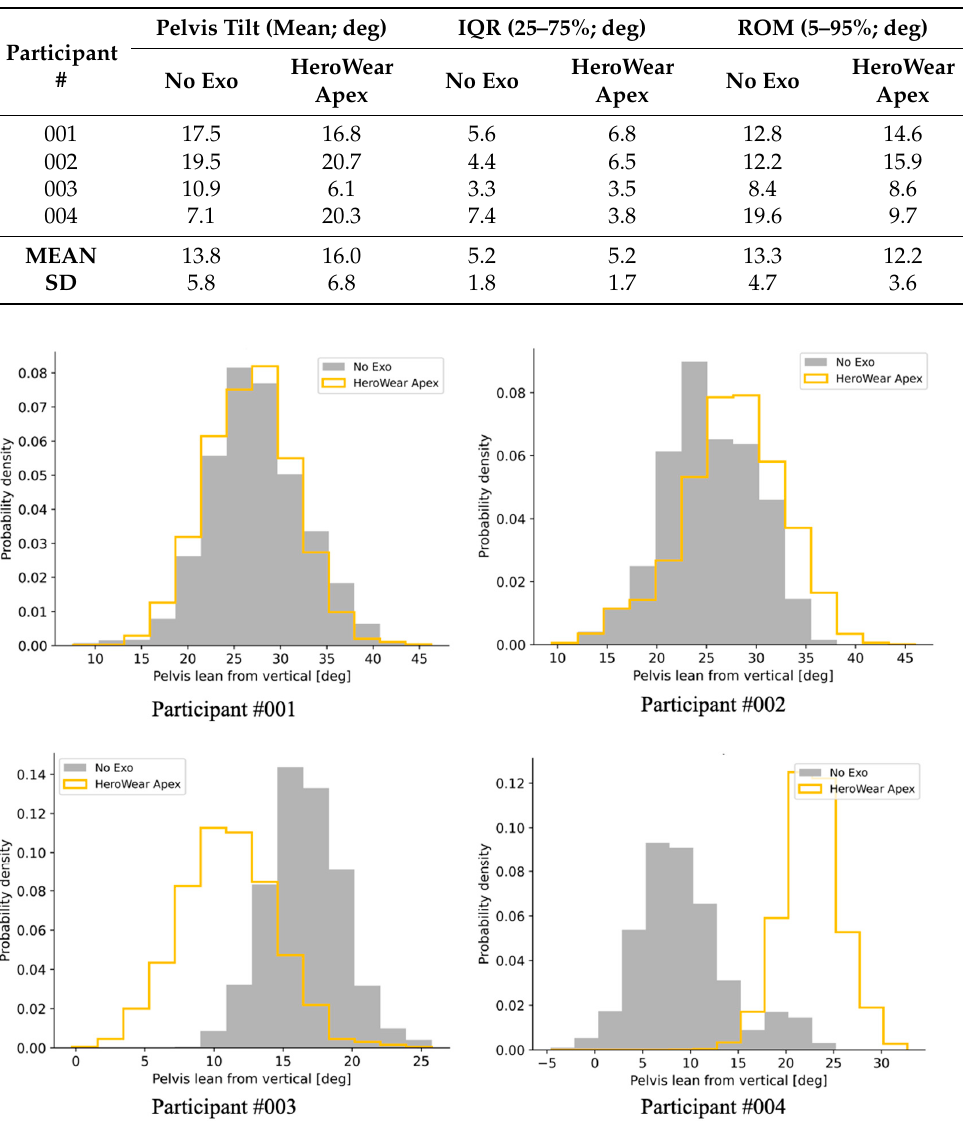
Table 5. Pelvis tilt (deg) for pushing the unloaded gondola at level ground.